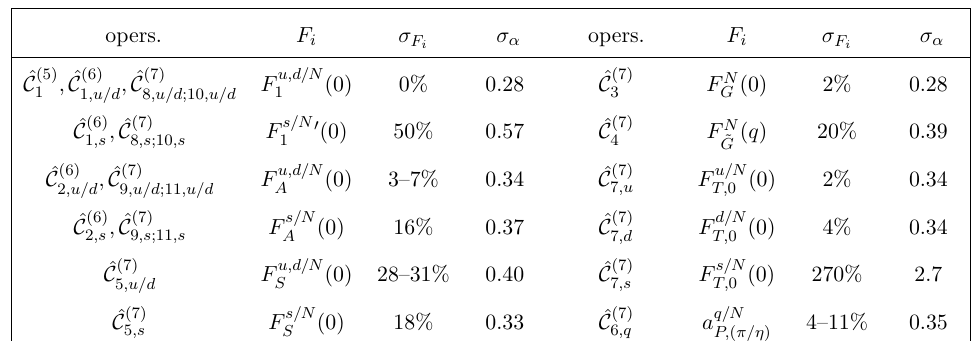
Table 1 . Form factors uncertainties, (cid:27) F CE (cid:23) NS cross sections, (cid:27) (cid:11) , for di(cid:11)erent Wilson coe(cid:14)cients ^